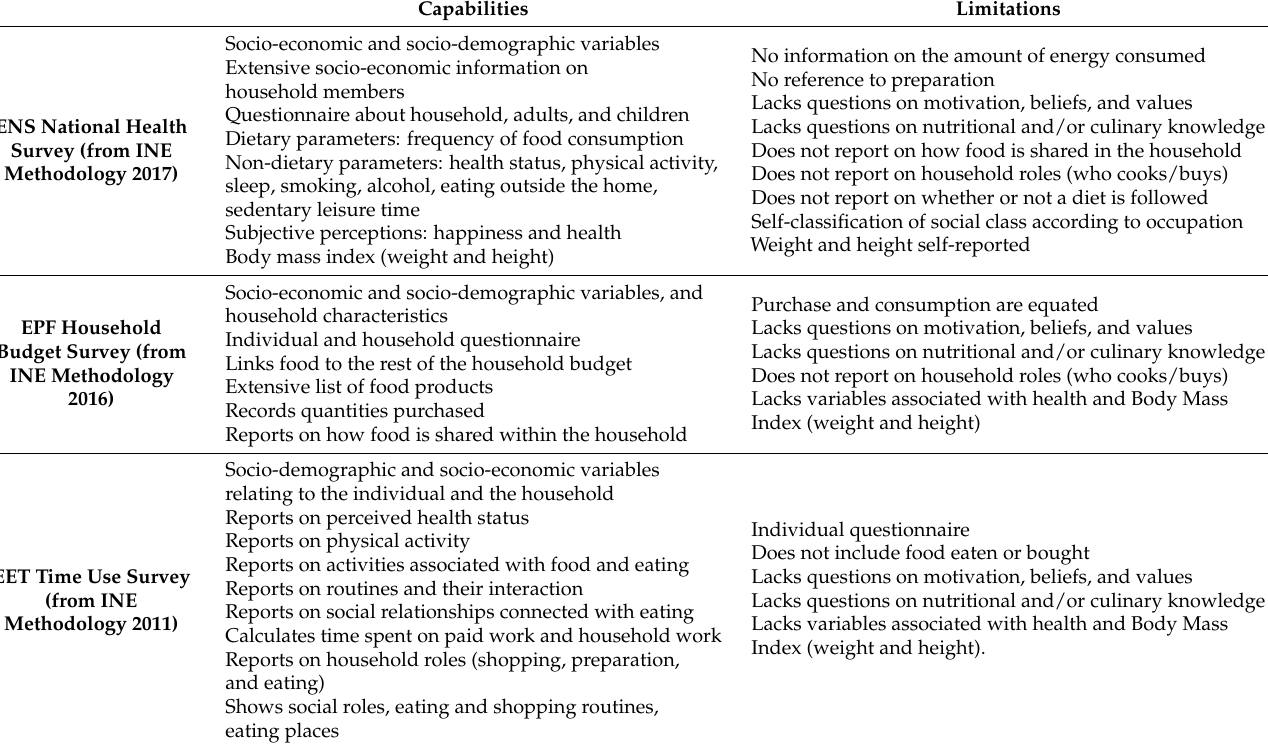
Table 2. Capabilities and limitations of the National Health Survey (ENS), the Household Budget Survey (EPF), and the Time Use Survey (EET) for capturing the social factors involved in obesity. Capabilities